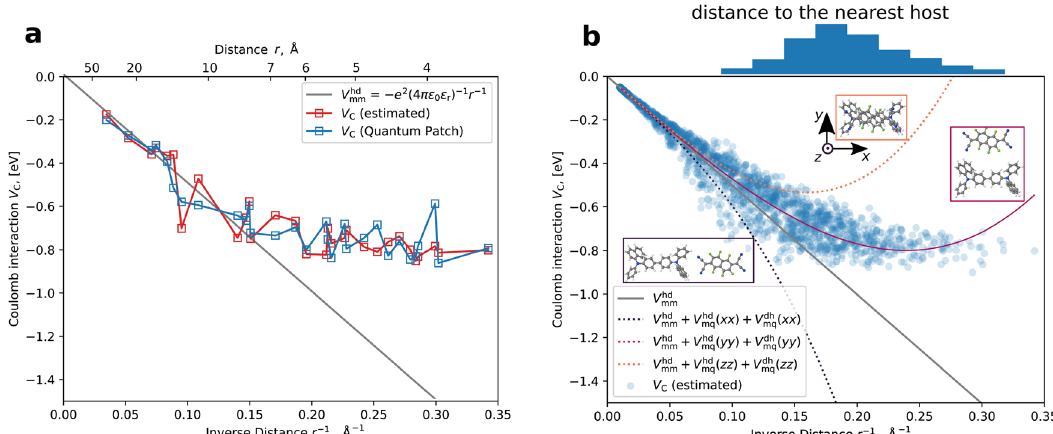
Fig. 2 | Short-range overscreening effect. a Dependence of the ICT state binding energy V C between charged host-dopant pairs on the inverse distance between them, r − 1 , in NPB:F 6 TCNNQ (5%), computed with quantum embedding (Quantum- Patch, (blue)) method and estimated via a multipole representation (red), in comparison with classical Coulomb interaction between two monopoles in polar- izable medium with dielectric permittivity ϵ r =2.7) (gray line). For short distances, V